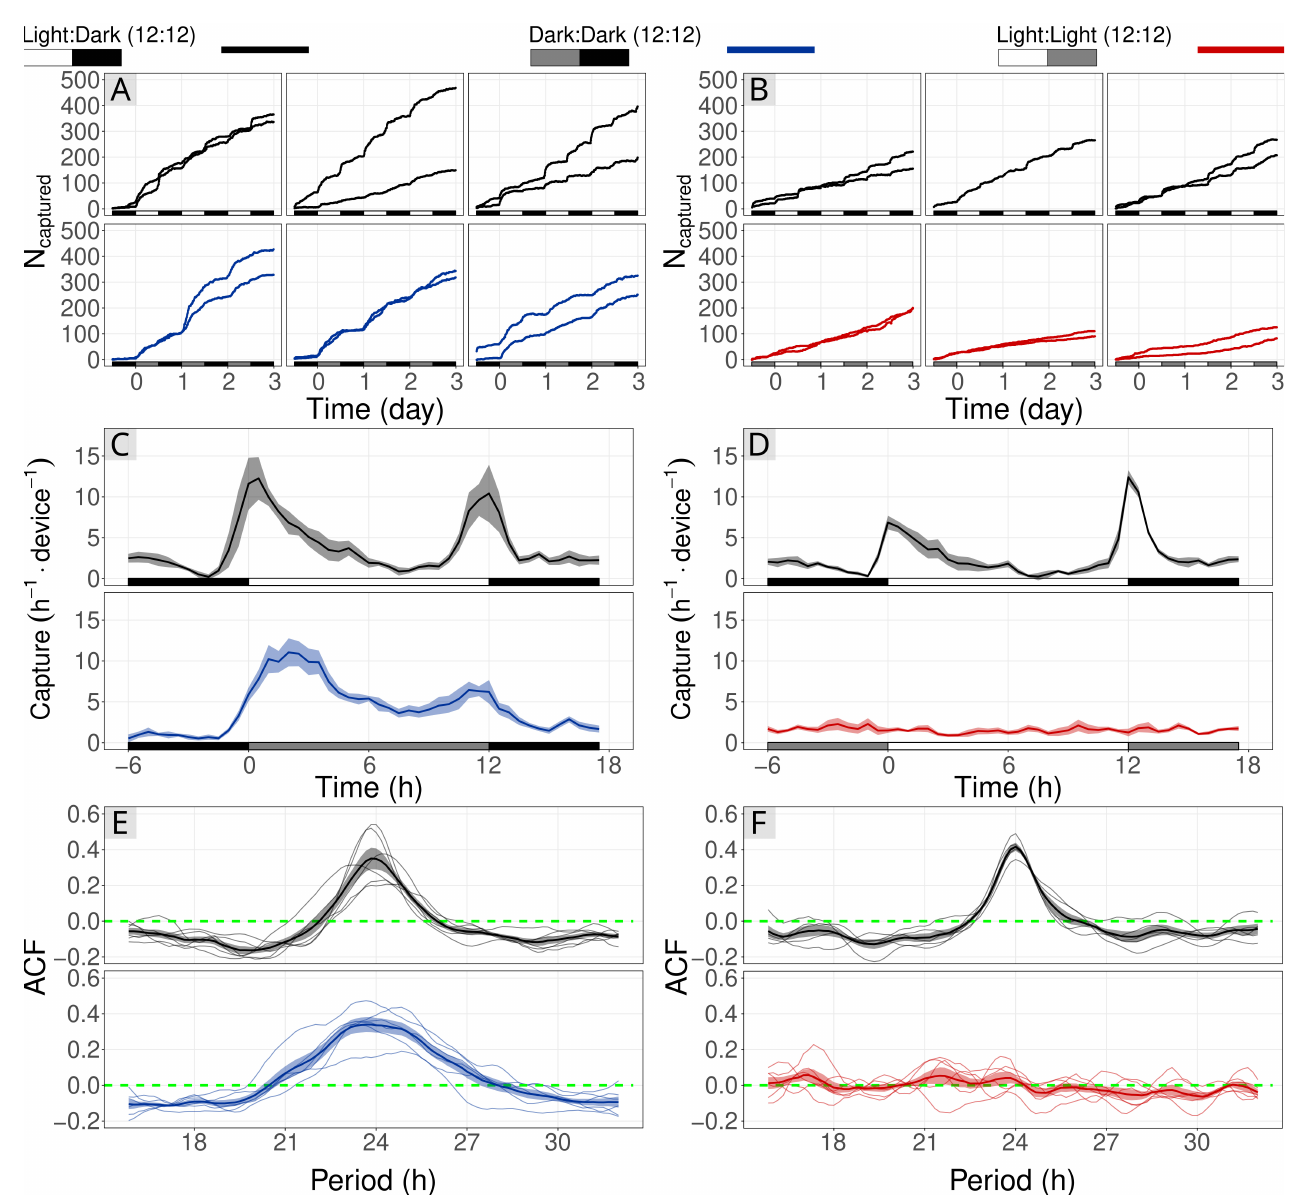
Fig 4. Sticky Pis can monitor circadian rhythms of free-moving populations in the laboratory. Vinegar flies, Drosophila melanogaster , were held in a large cage with a Sticky Pi. We conducted 2 experiments to show the effect of Light:Light (red; A, C, E) and Dark:Dark (blue; B, D, F) light-regimes on capture rate. Each was compared to a control population that remained in the entrainment conditions: Light:Dark, 12:12 h cycles (black). (A, B) Cumulative number of insects captured over time. Columns of the panels correspond to independent full replicates. We used 2 devices per condition, in each full replicate. (C, D) Capture rates over circadian time. As expected, capture rates in LD and DD show a clear crepuscular activity, but no activity peak in constant light. (E, F) Autocorrelation of capture rates. Each thin line represents a series (i.e., one device in one full replicate), and the thick line is the average autocorrelogram. The green dotted line shows the expectation under the hypothesis that there is no periodic pattern in capture rate (ACF). The underlying data for this figure can be found on figshare [20]. ACF, AutoCorrelation Function.